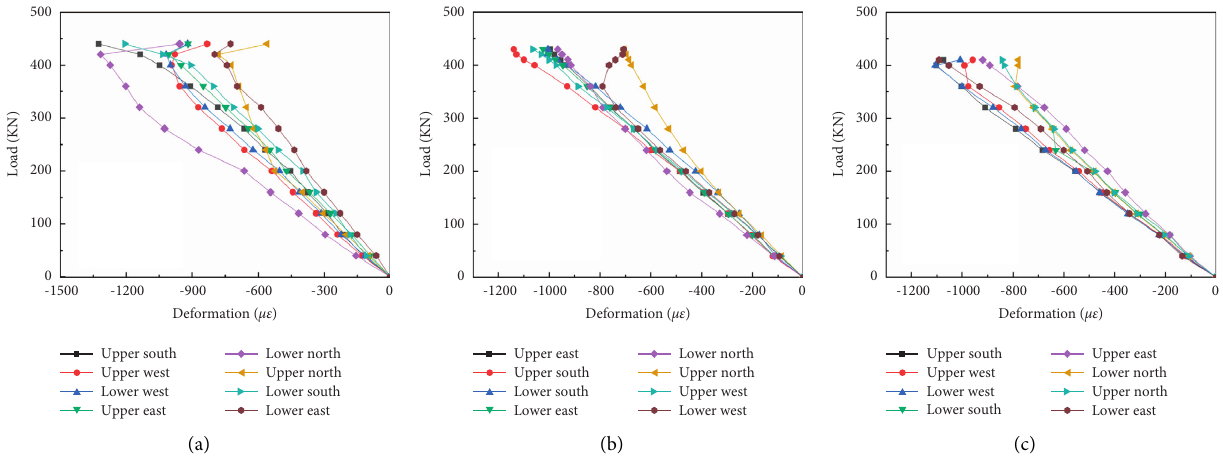
Figure 42: CF series load-strain curves: (a) CF-1, (b) CF-2, and (c) CF-3. Table 4: Test values, finite element analysis, and theoretical calculation analysis.